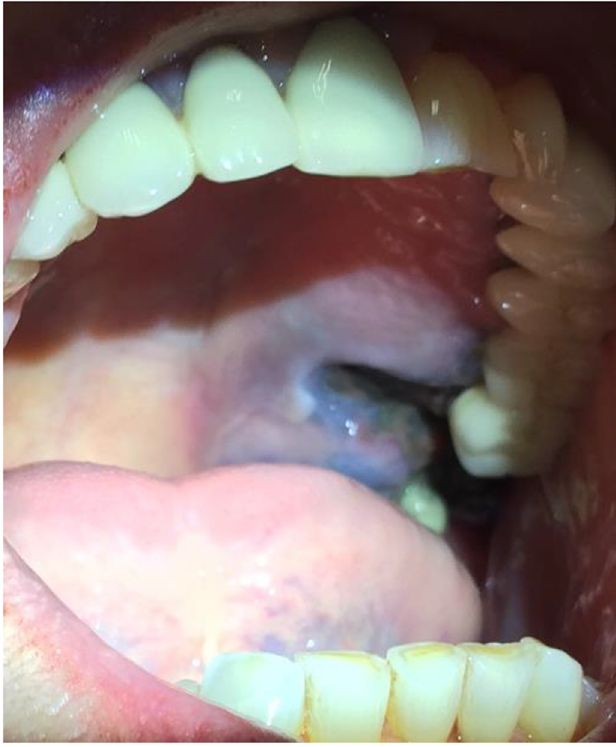
Fig. 1. Intraoral photograph showing melanocyte in fi ltration in the gingival mucosa and the tissue loss around the second maxillary left molar.